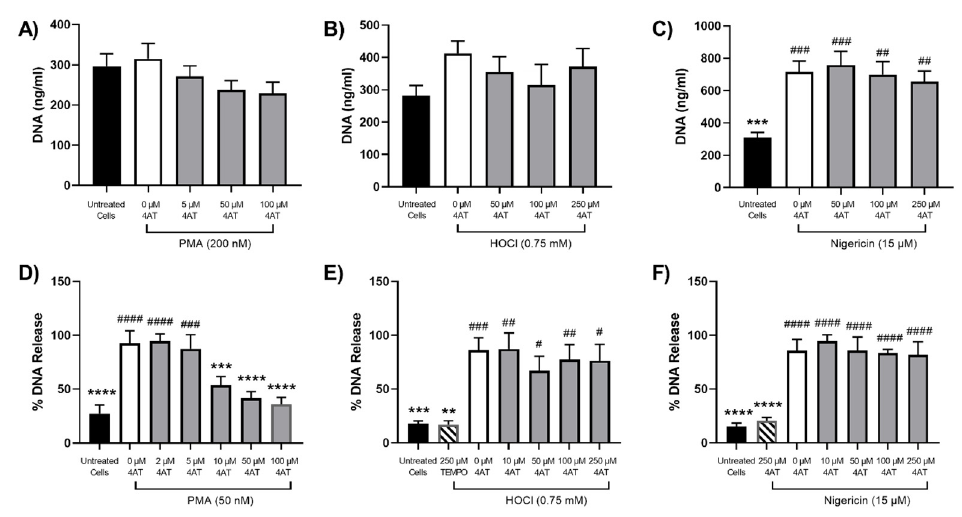
Figure 8. Effect of 4-amino TEMPO on NET release from neutrophils stimulated with PMA, HOCl or nigericin. Panels ( A – C ): differentiated PLB-985 cells (1 × 10 6 cells) were incubated with 4-amino (5–250 µM) for 15 min at 37 °C prior to the addition of ( A ) PMA (200 nM), ( B ) HOCl (0.75 mM) or ( C ) nigericin (15 µM) for 4 h at 37 °C. Panels ( D – F ): primary neutrophils (1 × 10 6 cells) were incubated with 4-amino TEMPO (2–250 µM) for 15 min at 37 °C prior to the addition of ( D ) PMA (50 nM), ( E ) HOCl (0.75 mM) or ( F ) nigericin (15 µM) for 3 h at 37 °C. Following treatment, NETs were released by the addition of DNase (40 U) for 15 min and quantification of extracellular DNA using a Quant-iT TM PicoGreen TM dsDNA Assay kit. Data are presented and analysed as described in Figure 4.